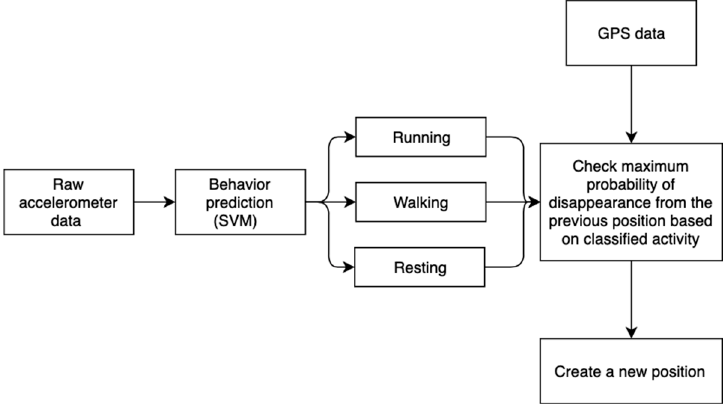
Figure 2. The proposed algorithm of the algorithm for reducing GPS error. Research data analysis is accompanied by receiving raw data stage to classify the activities of the goat. Animal behavior is classified using the real-time SVM prediction model. Finally, the method decides to create a new correct position.